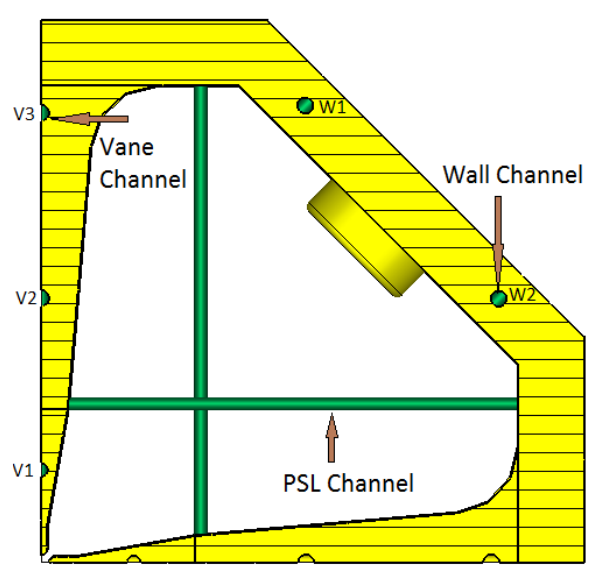
Figure 16. Diagram of the cooling channel.